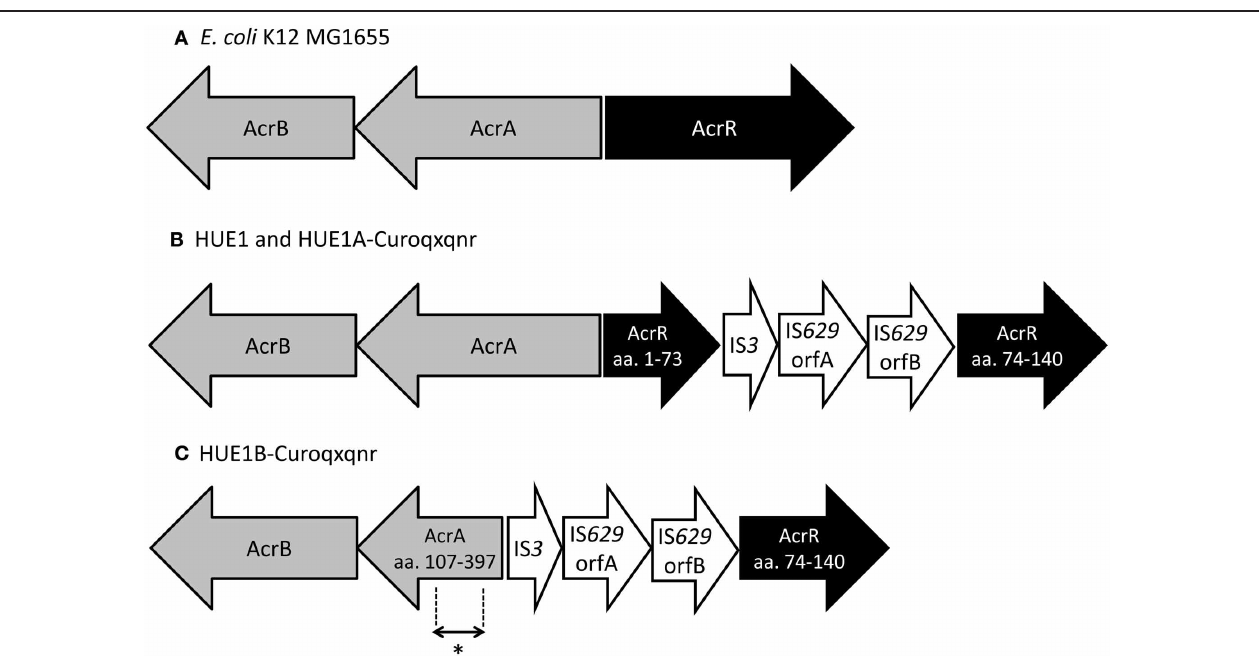
FIGURE 2 | Schematic representation of the acrAB − acrR region in HUE1, group A mutants, and group B mutants. (A) Escherichia coli K12 MG1655 (accession no U00096). (B) HUE1 and HUE1A-Curoqxqnr (group A).